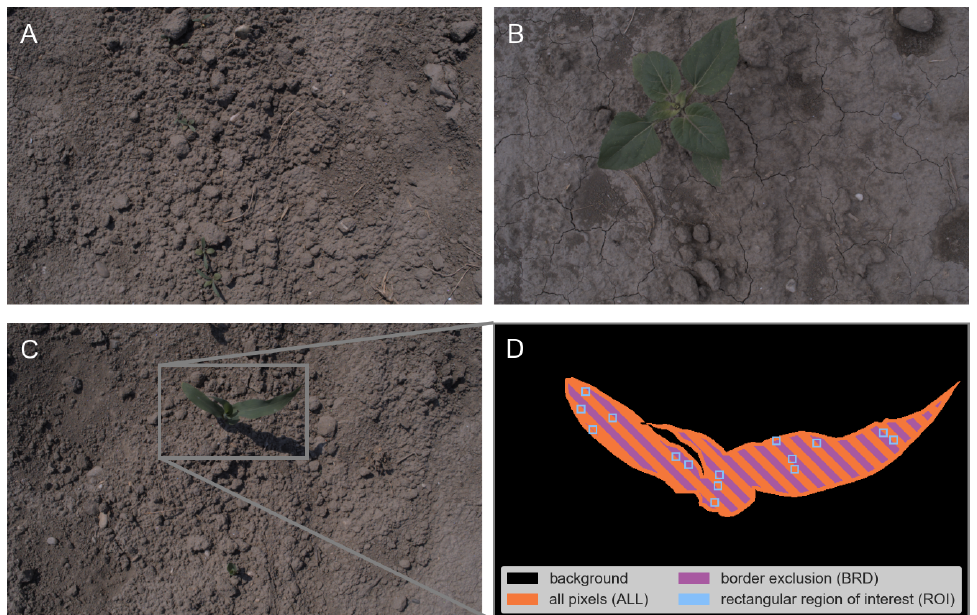
Figure 1. ( A – C ): Examples of captured RGB images in different parcels from different dates under sunny ( A , C ) and cloudy ( B ) natural light conditions. ( D ): Illustration of used pixel selection criteria for selecting the plant pixels of image C. Black pixels show non vegetation parts of the image (background, soil). ALL uses the full hand-annotated segmentation mask, BRD removes pixels from the annotation mask border and ROI uses the pixels within the blue rectangular regions of